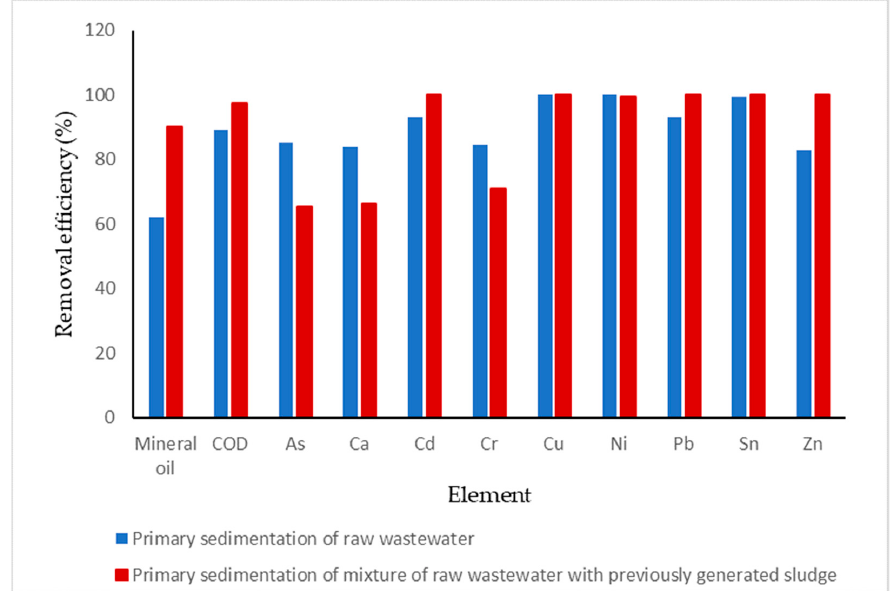
Figure 4. Comparison of removal efficiency of mineral oil, COD, As, Ca, Cd, Cr, Cu, Ni, Pb, Sn, Zn by primary sedimentation of raw wastewater followed by EF/EC process, and primary sedimentation of a mixture of raw wastewater with previously generated followed by EF/EC process.